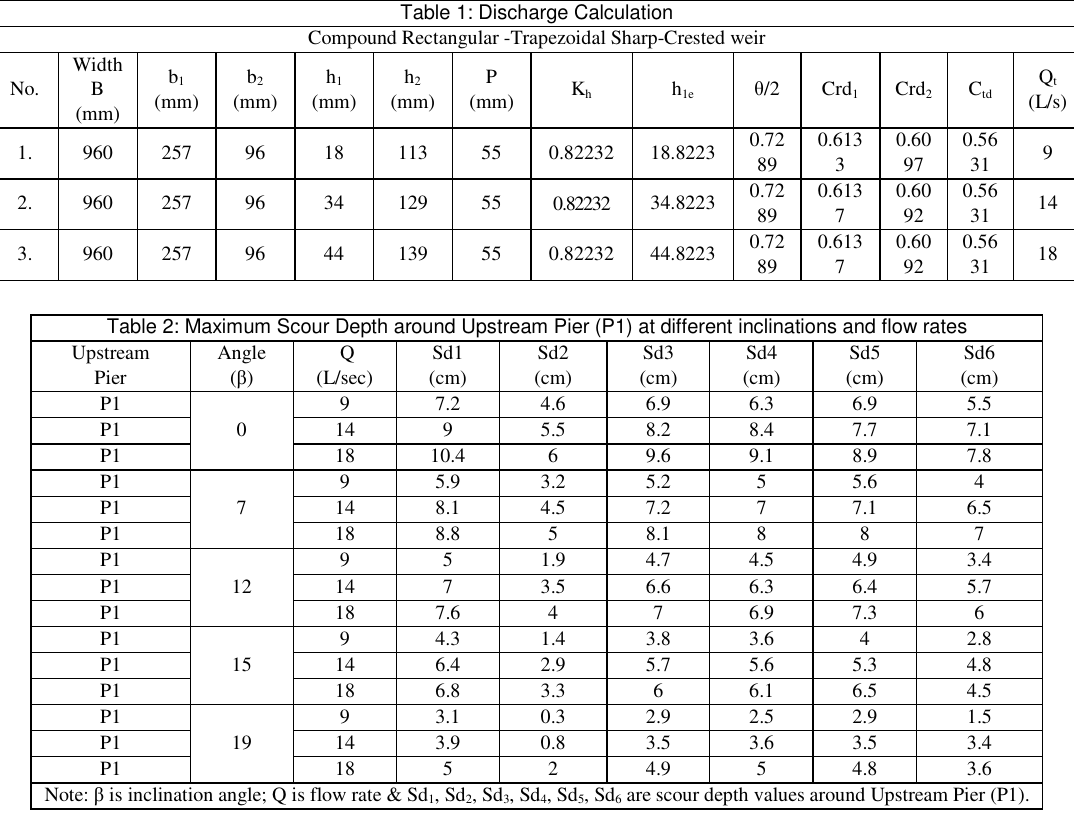
Compound Rectangular -Trapezoidal Sharp-Crested weir